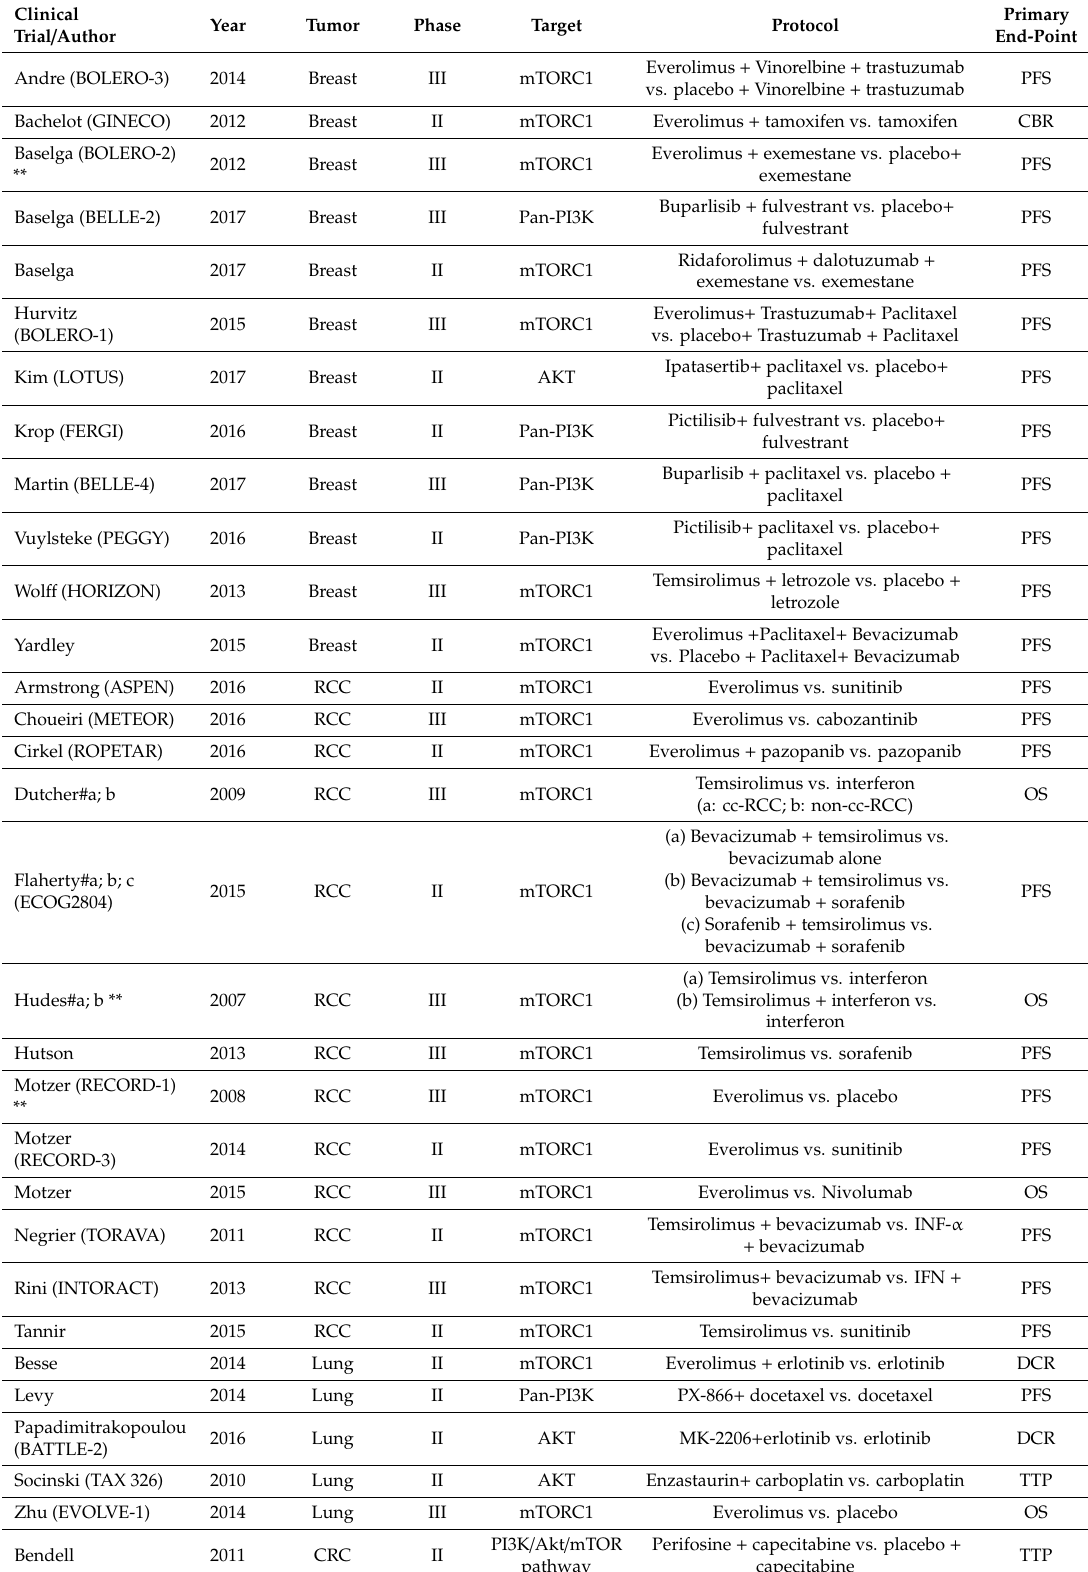
Table 2. Di ff erent PI3K / AKT / mTOR inhibitors under clinical development or approved for clinical use in SOLID